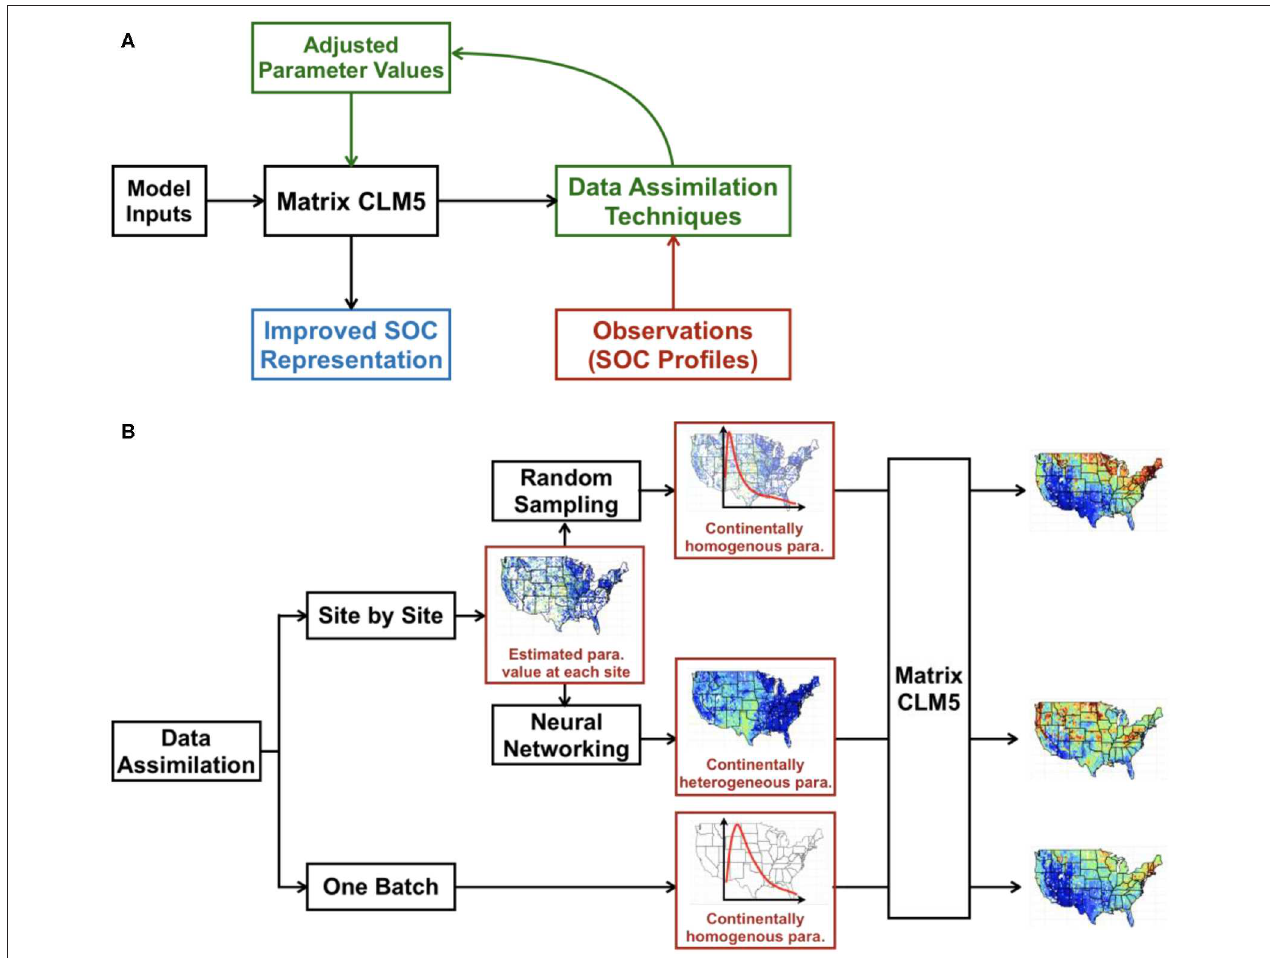
FIGURE 1 | Schema of integrating big data into SOC distribution maps by CLM5. In data assimilation (A) , we used NPP, soil temperature, and soil water potential as model inputs to drive the CLM5 model. The model output (i.e., analytical solution of vertical SOC content calculated through Equation 2 under the steady state assumption) will be compared with the observed SOC content in the data assimilation framework, the results of which will further guide the adjustment of parameter values of CLM5 to improve model representation of SOC distribution. The figure was adapted from https://www.hzg.de/institutes_platforms/cosyna/models/data_ assimilation/index.php.en. Two data assimilation methods were used and were further developed to generate SOC distribution maps across the conterminous United States (B) . Optimized parameter values at individual sites in the site-by-site method were either randomly sampled to generate the continentally homogeneous parameter distribution (i.e., all the sites use the same posterior parameter distribution to generate SOC distribution) or used in training, validating, and testing a neural network to predict parameter values at each grid of the map (continentally heterogenous parameter). The one-batch method can directly generate the continentally homogenous parameter distribution by taking all observational SOC profiles as one batch in data assimilation. The continentally homogeneous distributions by the random-sampling method and one-batch method and gridded maps of parameters by the neural networking method were then applied to CLM5 to generate the SOC distribution of the conterminous United